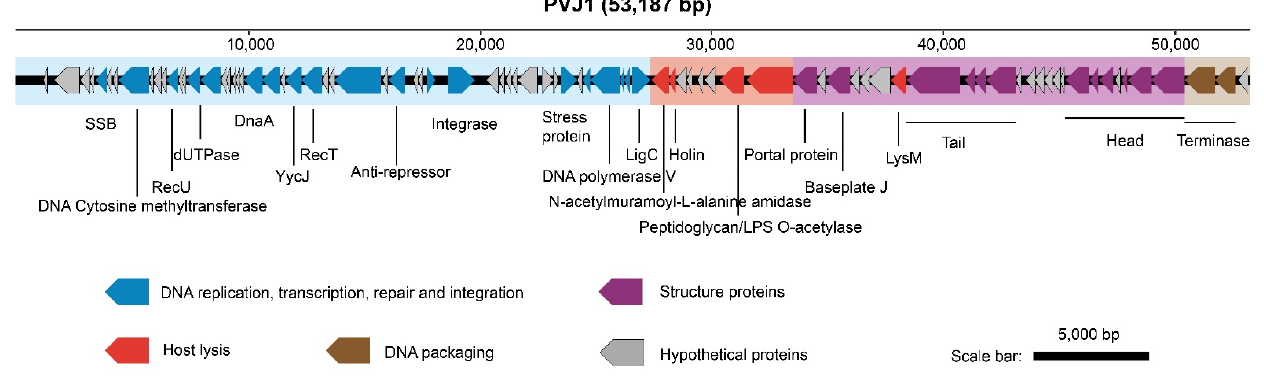
Figure 2. Genome organization of PVJ1. ORFs are shown with arrows oriented in the direction of transcription. Gene cassettes with putative functions are color coded as indicated.